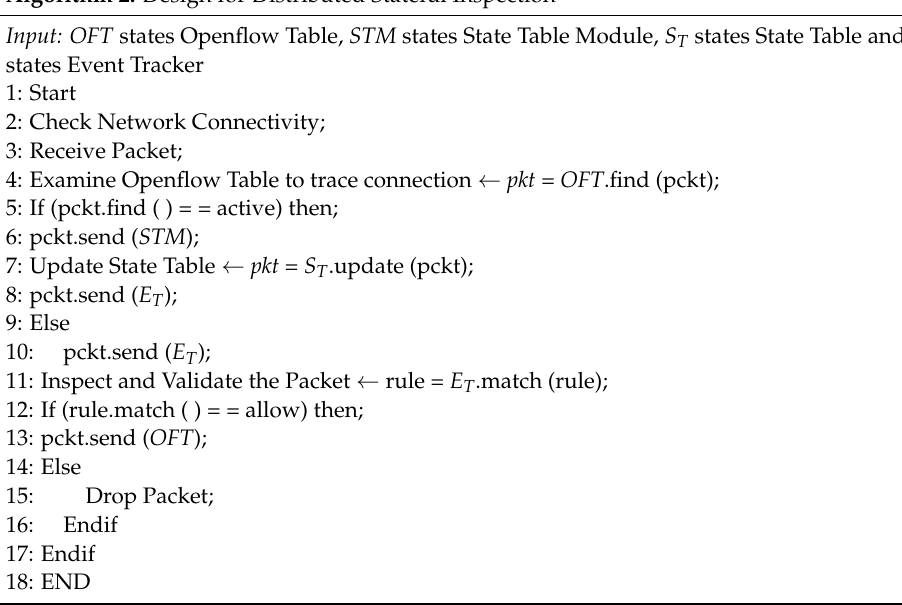
Algorithm 2: Design for Distributed Stateful